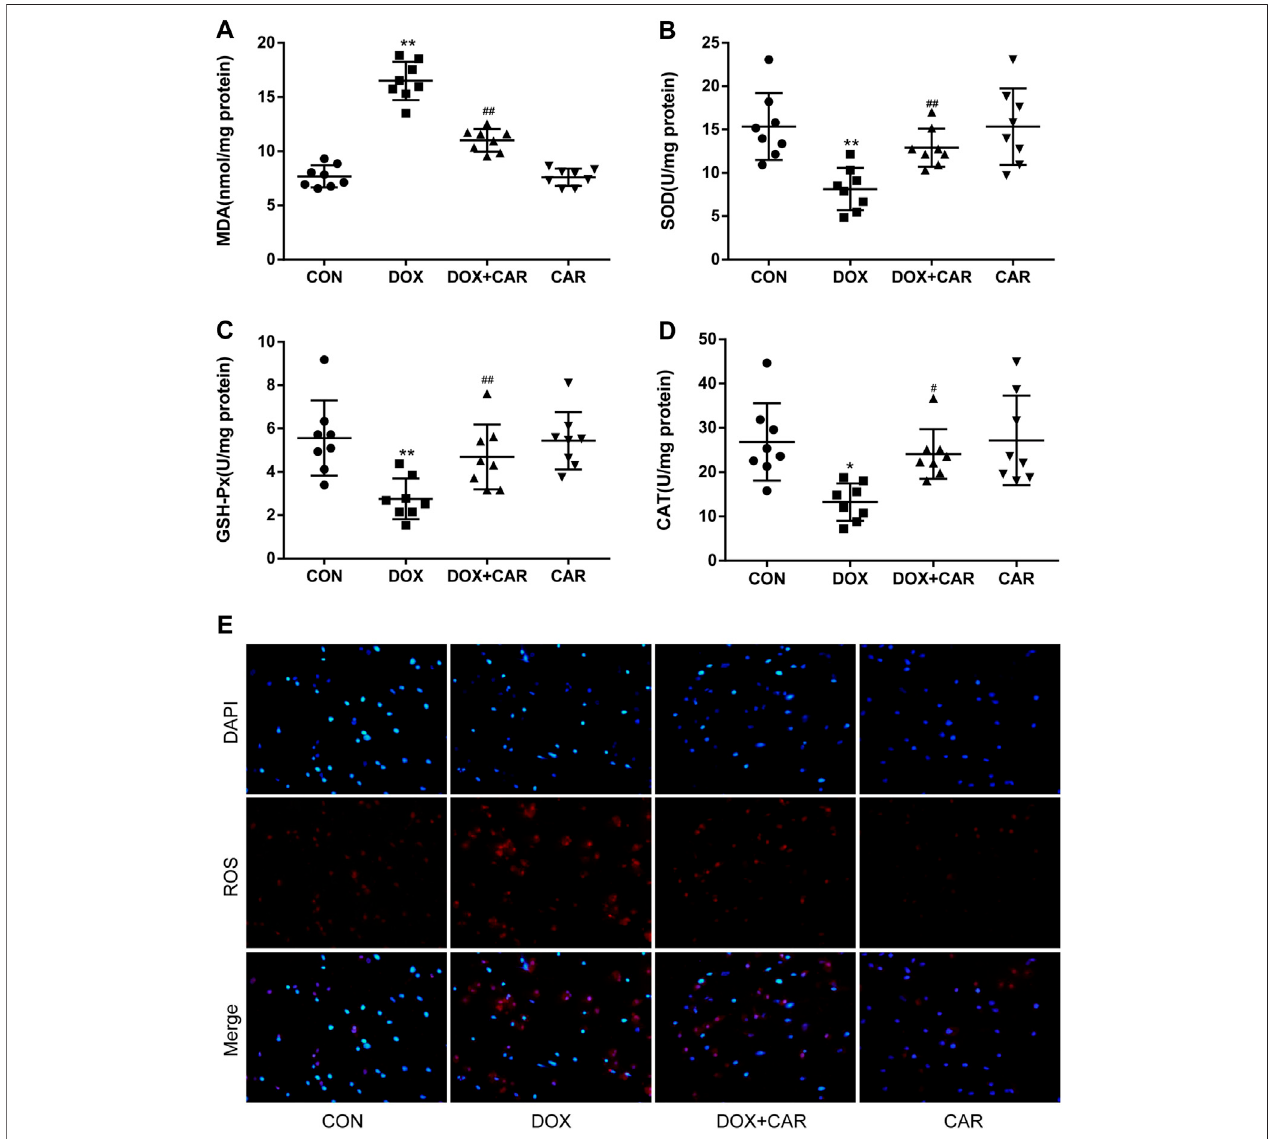
FIGURE3| CAR alleviated oxidative stressin myocardial tissues in ratand H9c2 cells treated withDOX.Quantitative analysis (A) MDA, (B) SOD, (C) GSH-Px, and (D) CAT. Representative images of cells stained with DAPI and DHE (E) , Scale = 20 μ m. Quantitative data are means ± SEM (n = 8). One-way ANOVA followed by